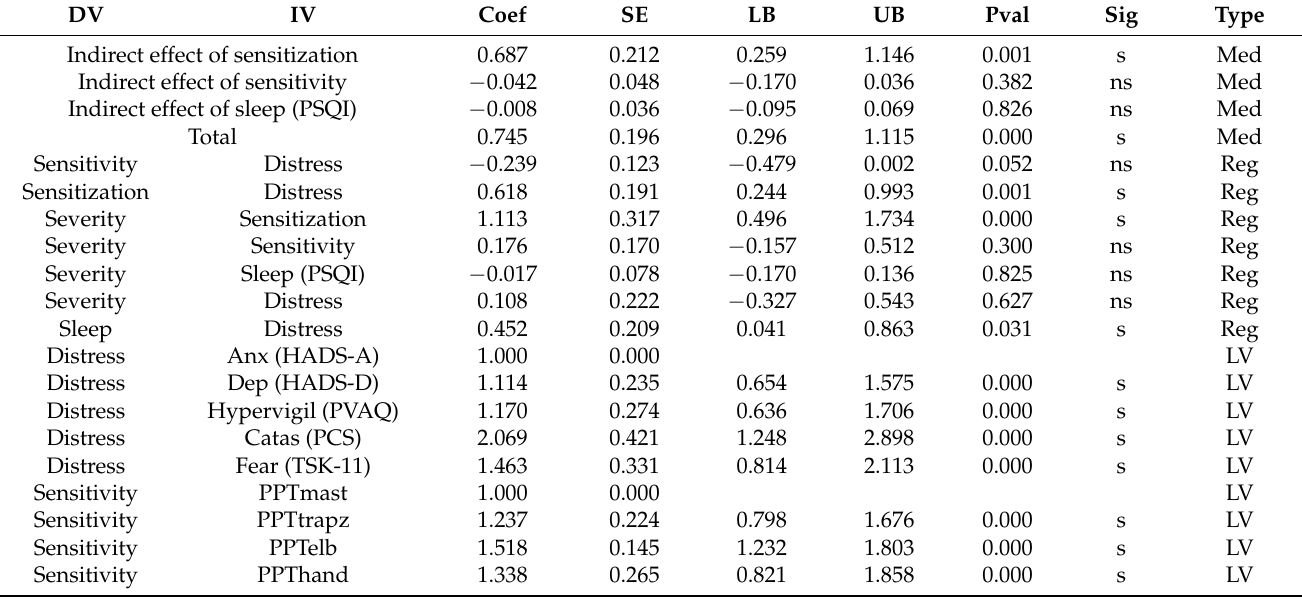
Table 2. Standardized parameter estimates for the